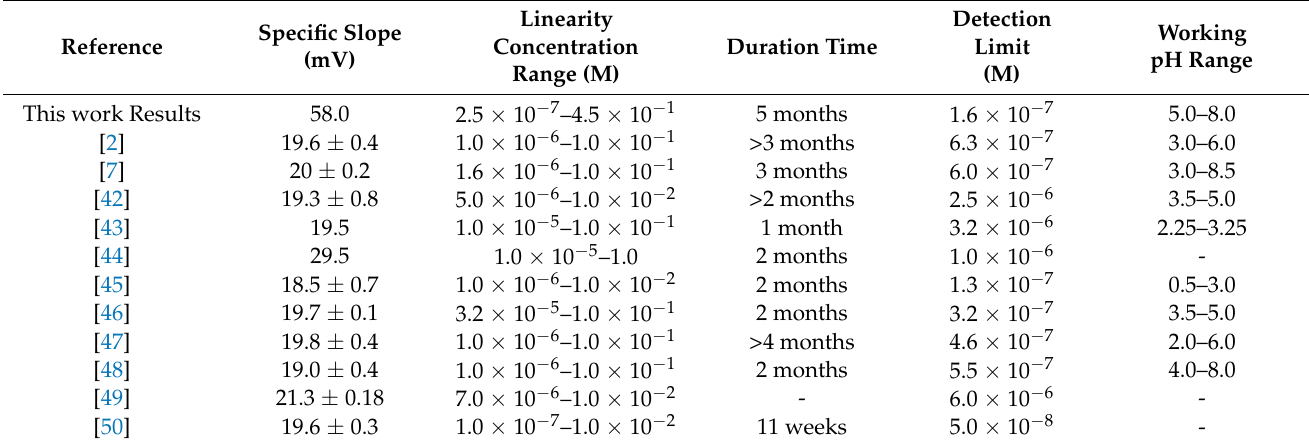
Table 4. Some interesting analytical validations of Al [DDTCT] in comparison with previously listed ion selective membrane sensors for aluminum